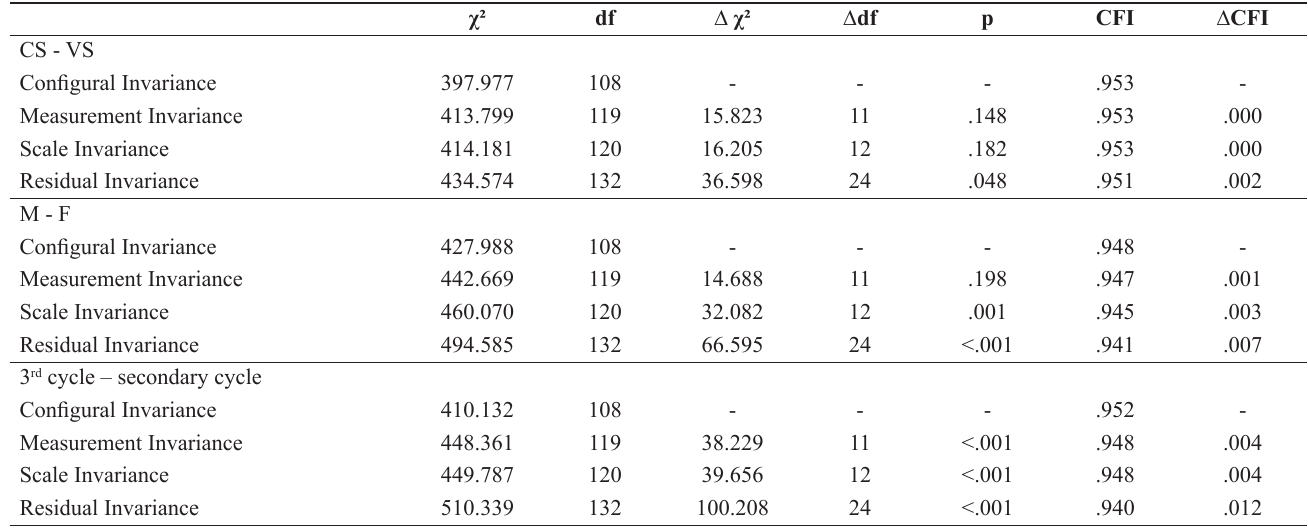
Table 4b. Fit indices for the invariance of the measurement model of the PESS in the Portuguese sample across sample, gender and cycles in the one factor model